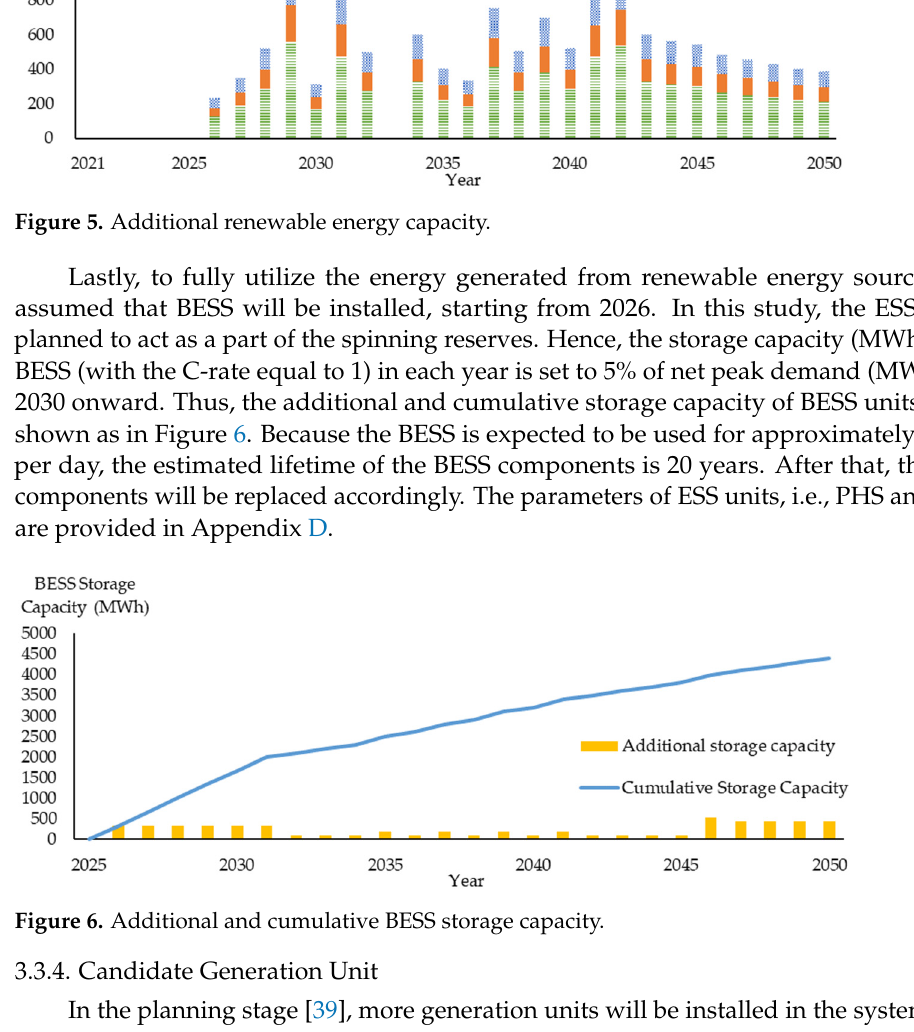
Figure 6. Additional and cumulative BESS storage capacity.